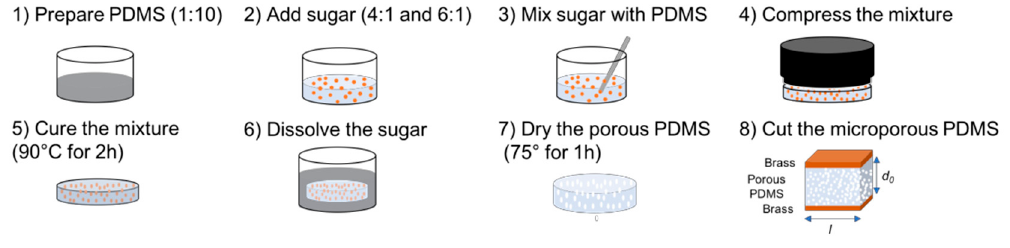
Figure 2. Fabrication process of the microporous PDMS